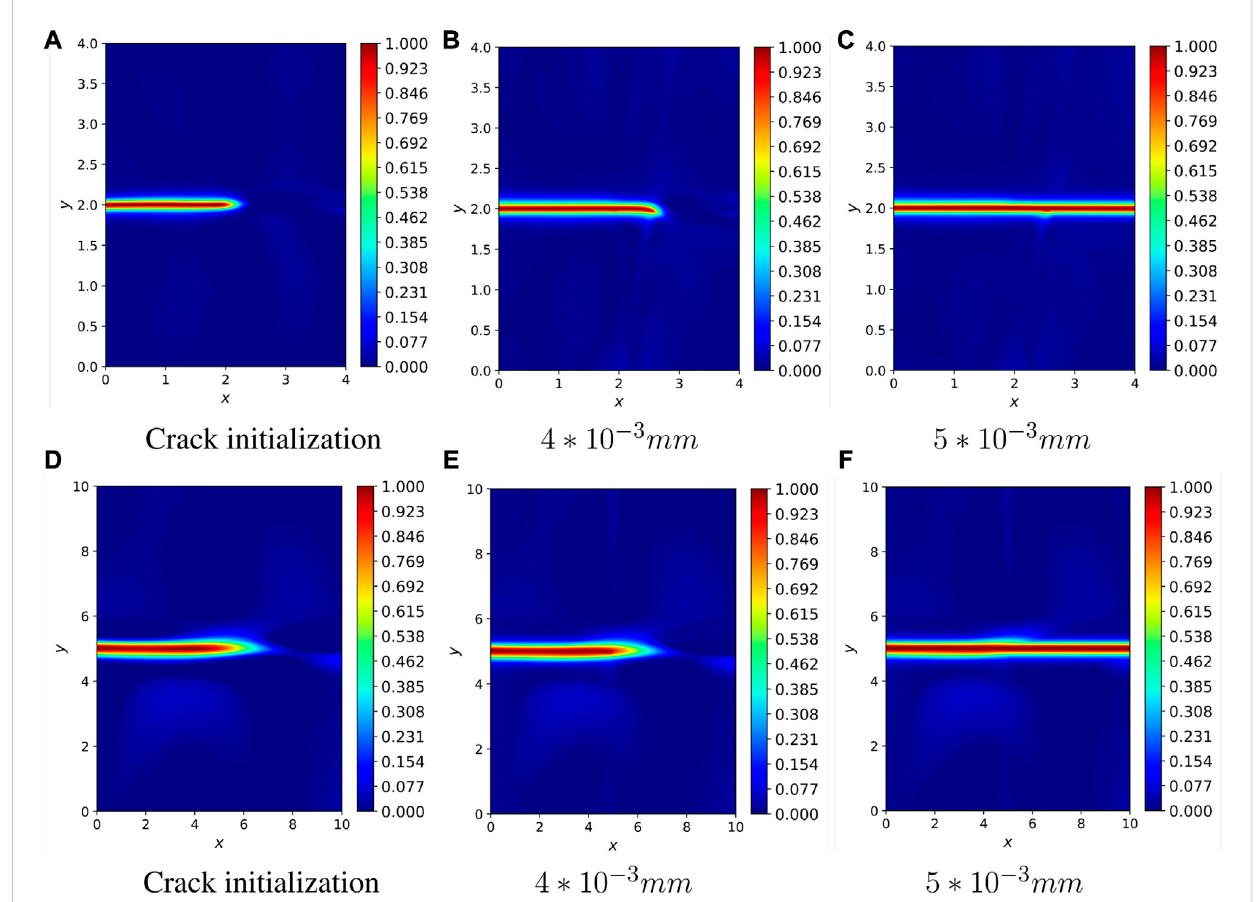
FIGURE 8 Phase fi eld images of single-edge notched plates with 4 and 10 times of model enlargement while maintaining the peak stress unchanged. The upperhalf: